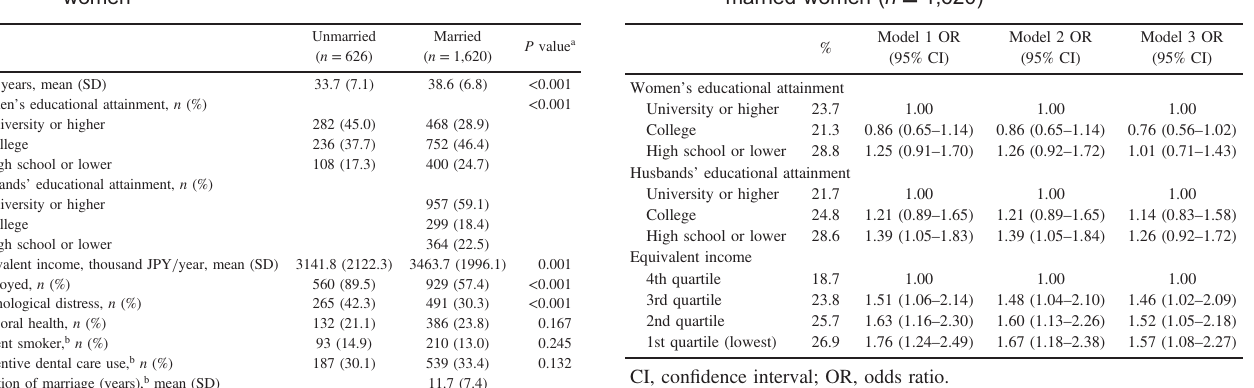
Table 3. Prevalence and odds ratios for poor oral health among married women ( n = 1,620)